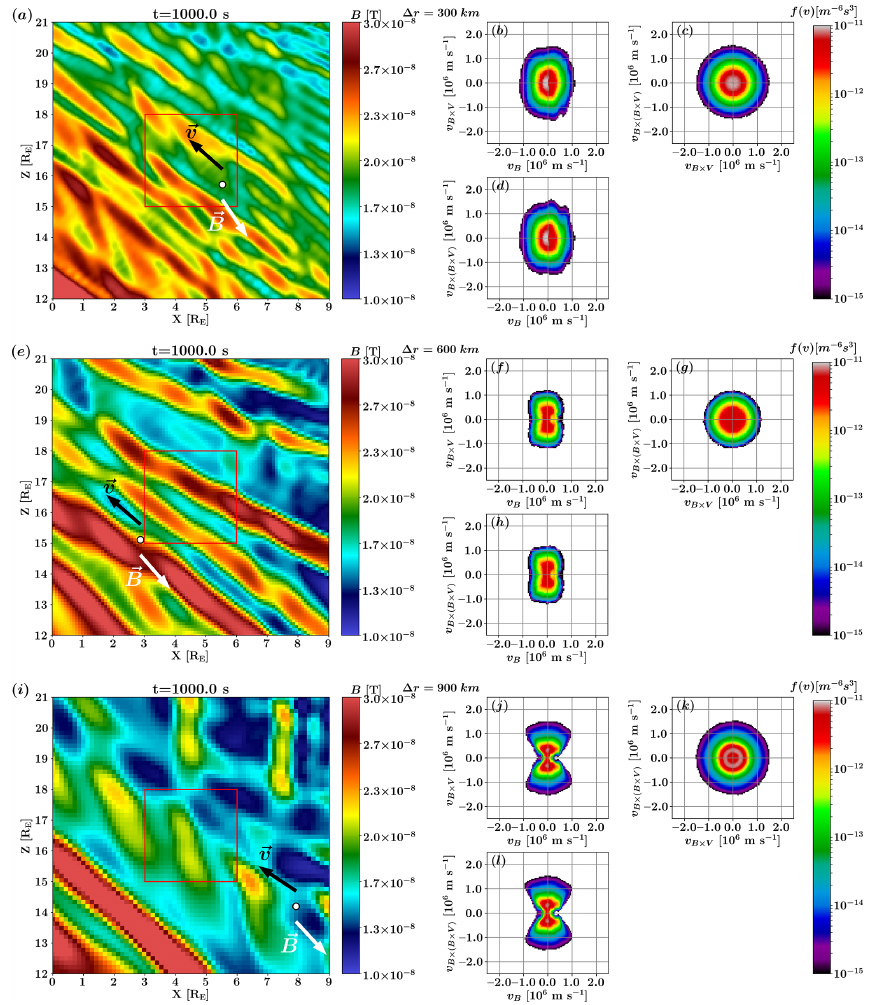
Figure 8. Colour map of the magnetic field (left) and velocity distribution functions in the three directions (right) located at the black and white circle. Panels (a) – (d) display the run with a resolution of (cid:49)r = 300km, panels (e) – (h) display the run with a resolution of (cid:49)r = 600km and panels (i) – (l) display the run with a resolution of (cid:49)r = 900km. The black arrow displays the plasma bulk velocity, and the white arrow displays the magnetic field direction; both are taken at the location indicated by the black and white circle. The red square displays the area where the 2D FFT is taken (Fig.